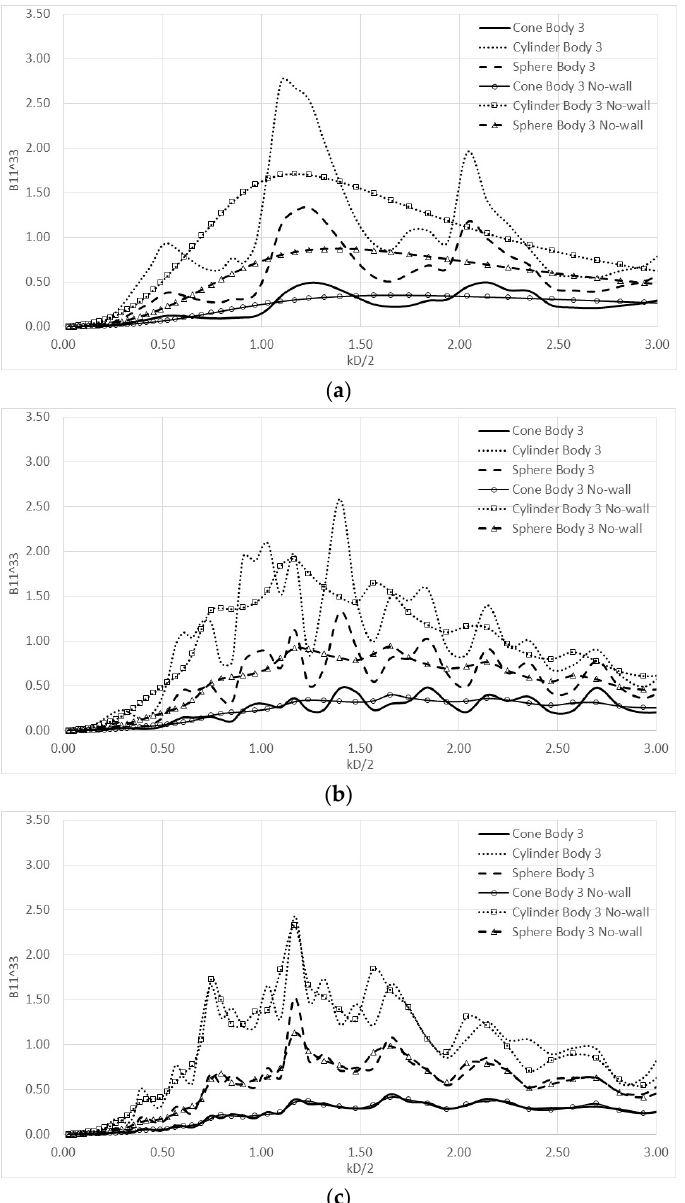
Figure 14. Dimensionless damping coefficient of the 3rd floater at the surge direction due to its motion at surge against kD/2, for the three different examined array configurations. Comparison with the corresponding damping coefficient of the same floater of the arrays without the presence of the breakwater: ( a ) parallel arrangement, C 1 ; ( b ) rectangular arrangement, C 2 ; ( c ) perpendicular arrangement, C 3 .